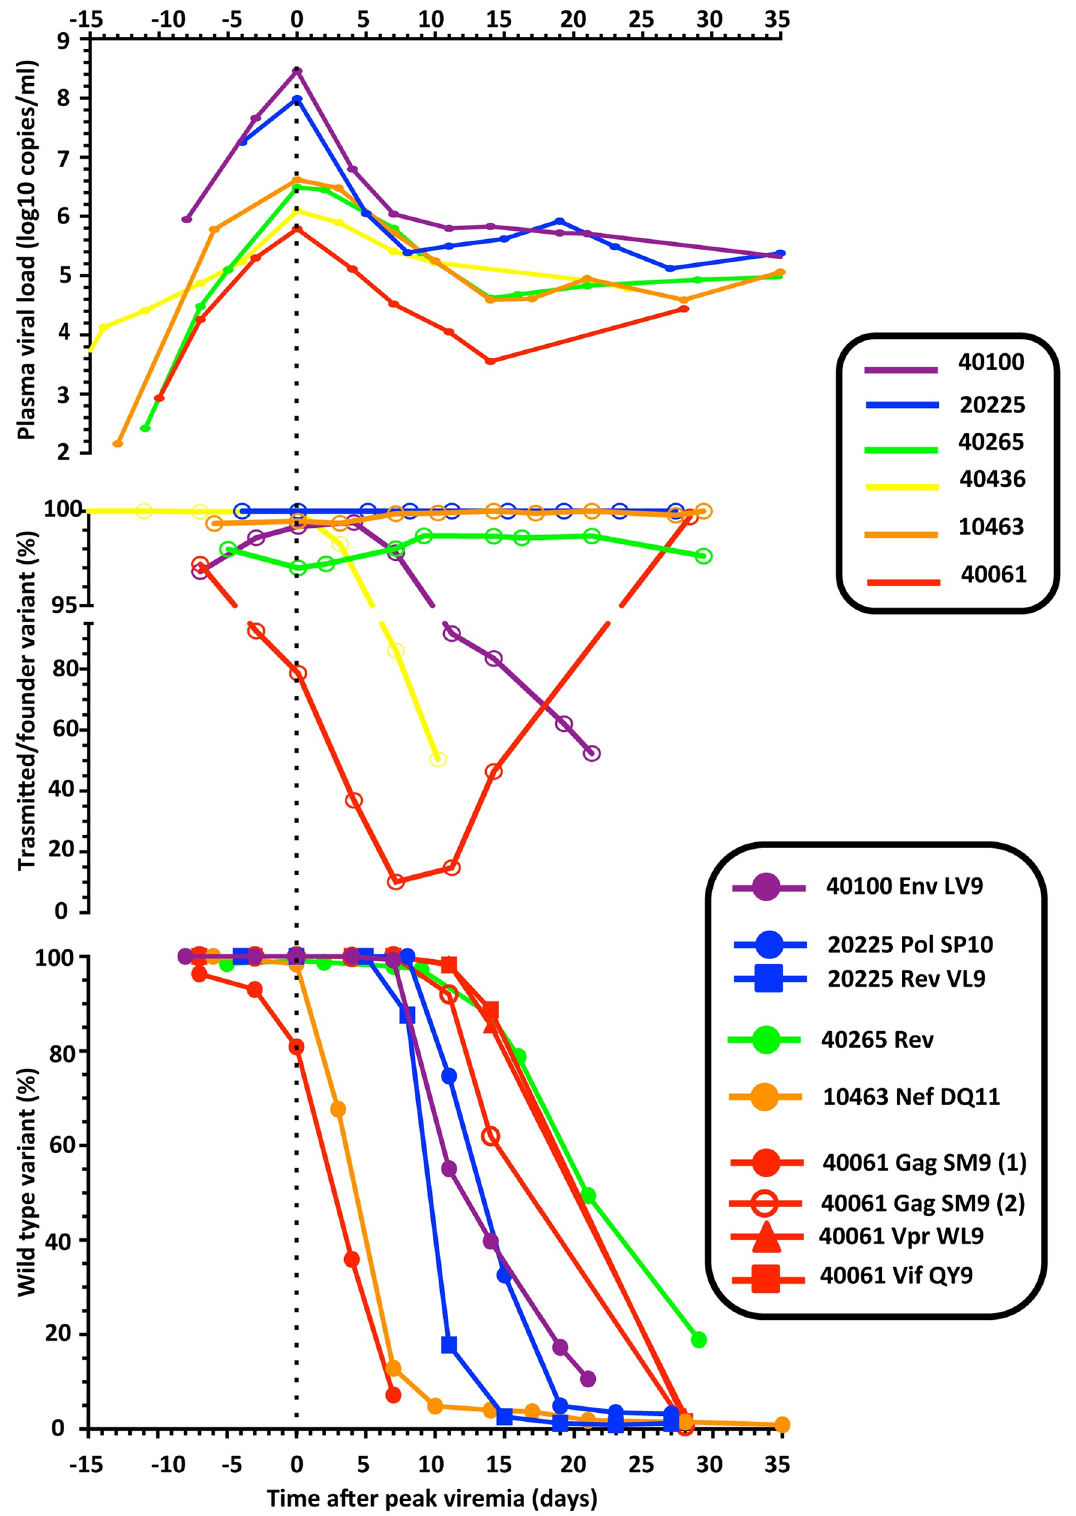
Fig 5. Summaryof viral dynamics during AHI. For the 6 participantsconsideredin the current study, we compare the dynamics of pVL, of the frequency of the major T/F lineage,and of viral escape from CTL responses. For the sake of